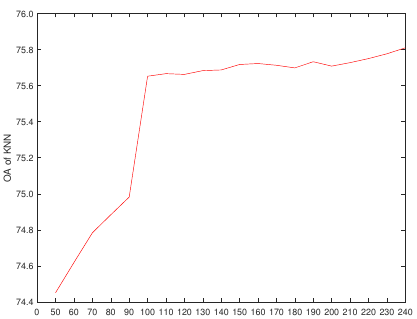
Figure 13. The overall accuracy (OA) values obtained by the proposed algorithm with different numbers of super pixel blocks.